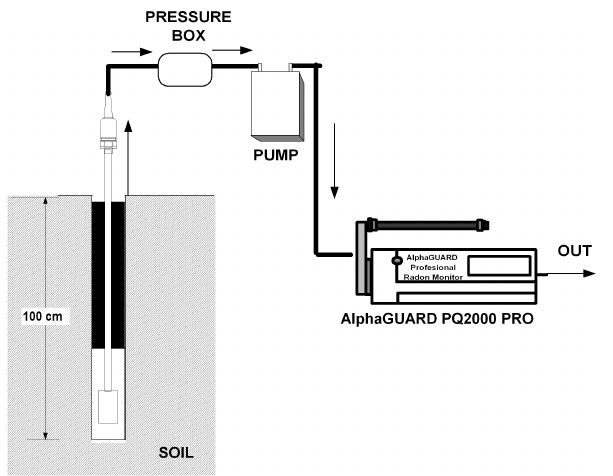
Fig. 3. Soil gas radon measurement.